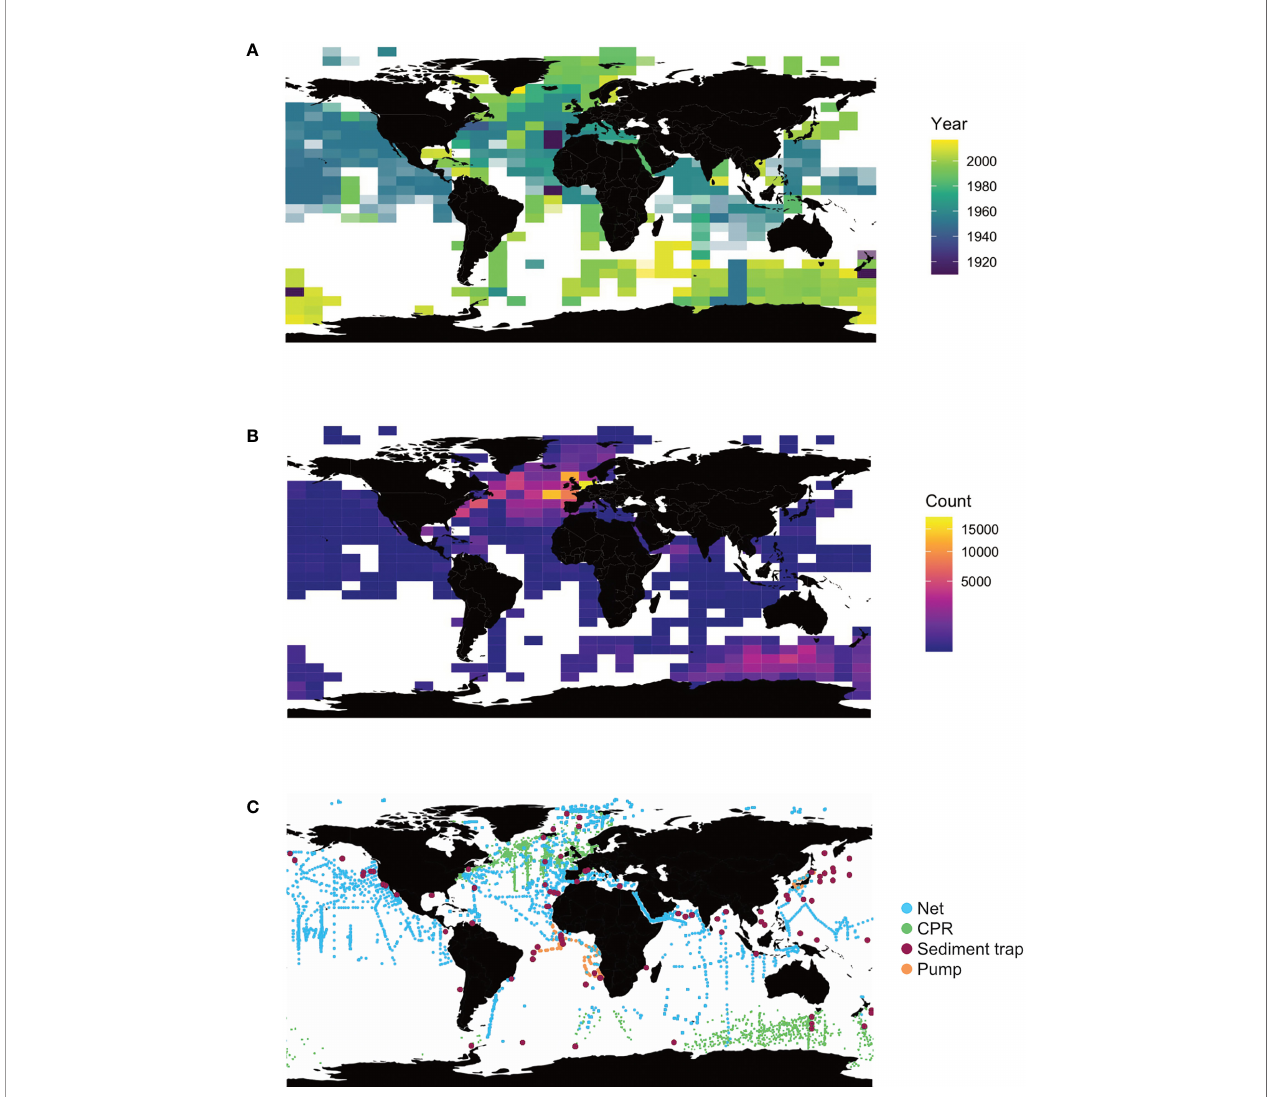
FIGURE 2 | Temporal and spatial coverage of data on planktonic Foraminifera included in the FORCIS database as of November 2020. Maps illustrate (A) the fi rst year of sampling, (B) the number of total observations starting from the fi rst year of sampling, and (C) sampling locations per sampling device in any 5.6° latitude by 11.25° longitude